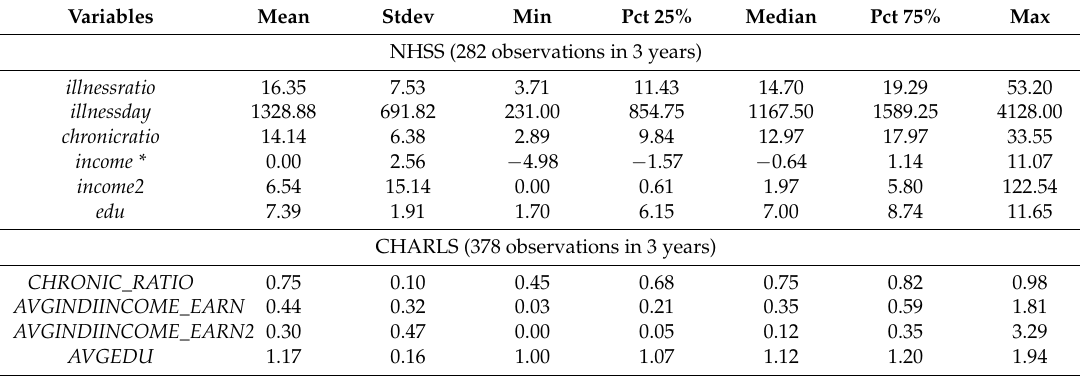
Table 2. Descriptive